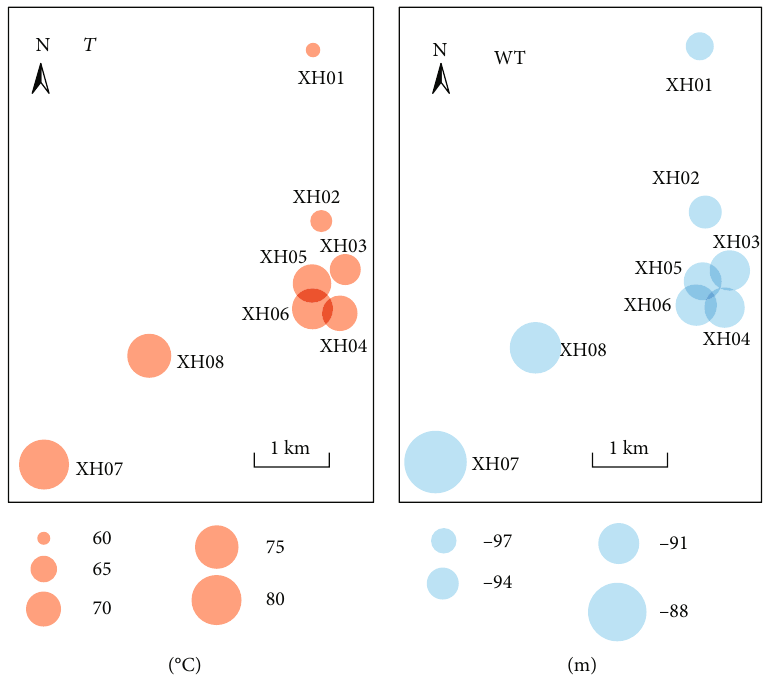
Figure 3: Groundwater temperature ( T ) and water table (WT) in Jixian aquifers of Xiongxian geothermal sector.